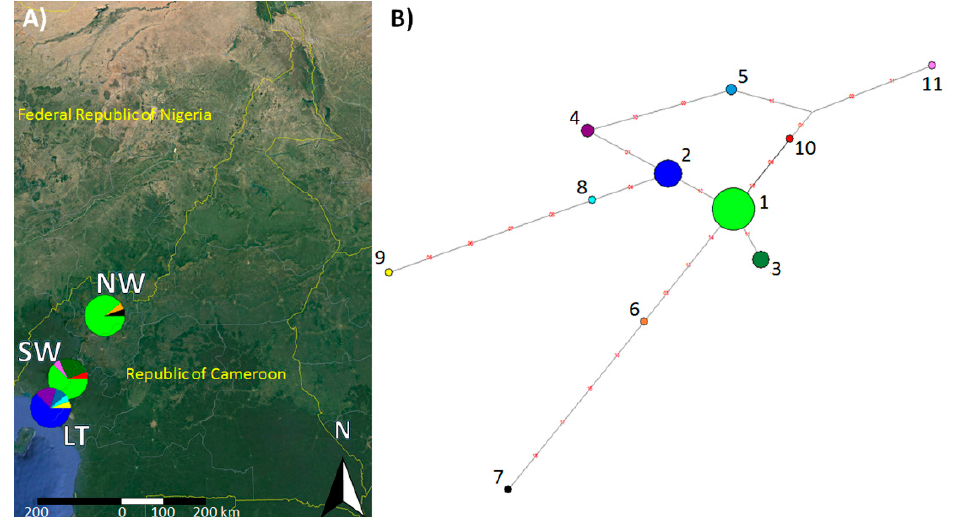
Figure 4. Prunus africana chloroplast haplotypes. ( A ) Distribution of haplotypes across all sampled regions. ( B ) Reduced median network of chloroplast DNA haplotypes; lines with markings represent single mutational steps; The size of the circles indicates the frequency of